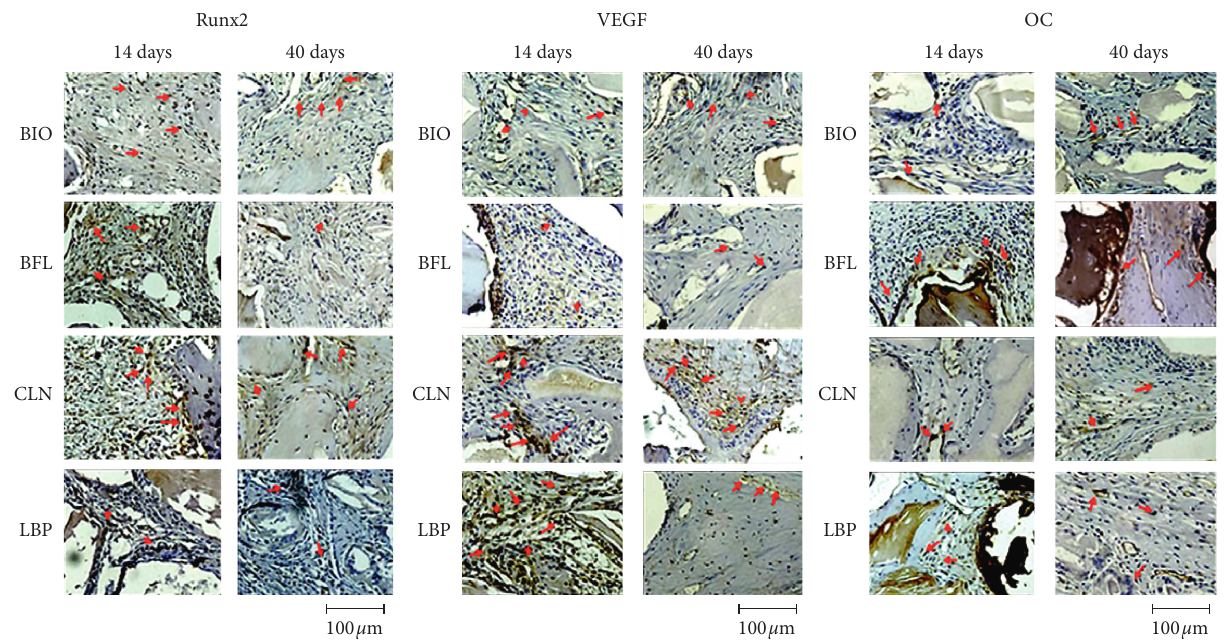
Figure 5: Representative images of the Runx2, VEGF, and OC immunostaining intensity (red arrow) in the experimental groups BIO, BFL, CLN, and LBP at 14 and 40 days postoperatively (original magnification